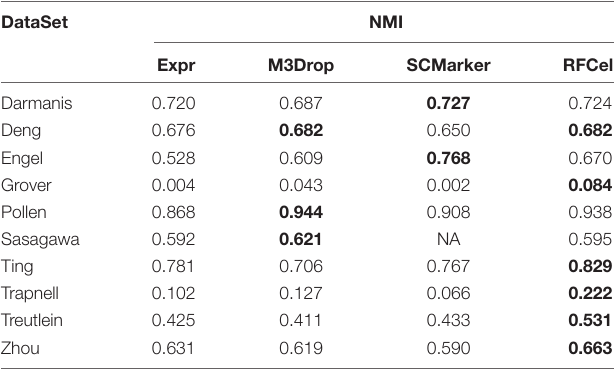
NA:The number of genes selected by SCMarker is 0, so no results are obtained. The bold values mean the highest or equally-highest value among different